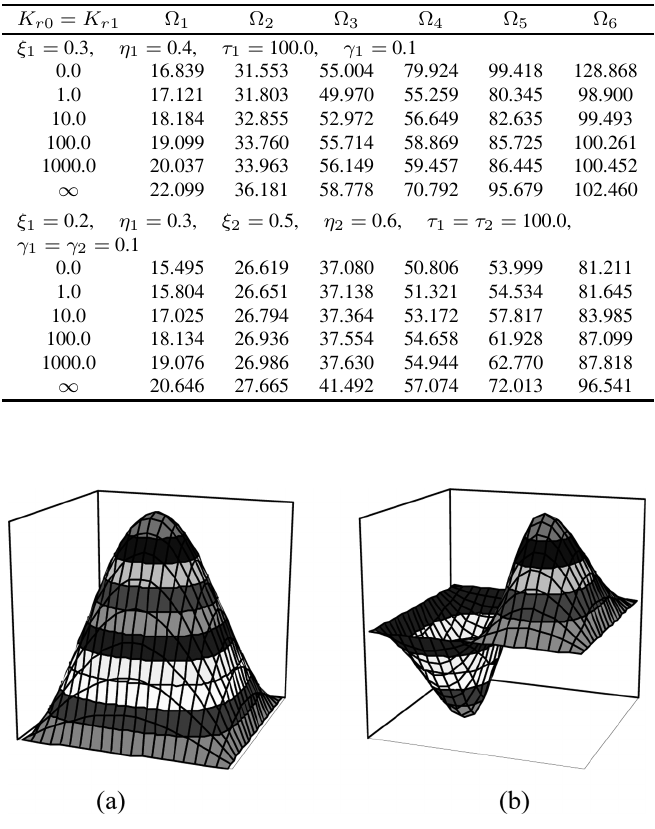
Fig. 5. The fi rst two coupled modes of a SSSS square plate with two sprung masses ( ξ 1 = 0 . 4 , η 1 = 0 . 4 , ξ 2 = 0 . 6 , η 2 = 0 . 4) . (a) the mode corresponding to Ω 1 = 14 . 407 , (b) the mode corresponding to Ω 2 = 28 . 267 .